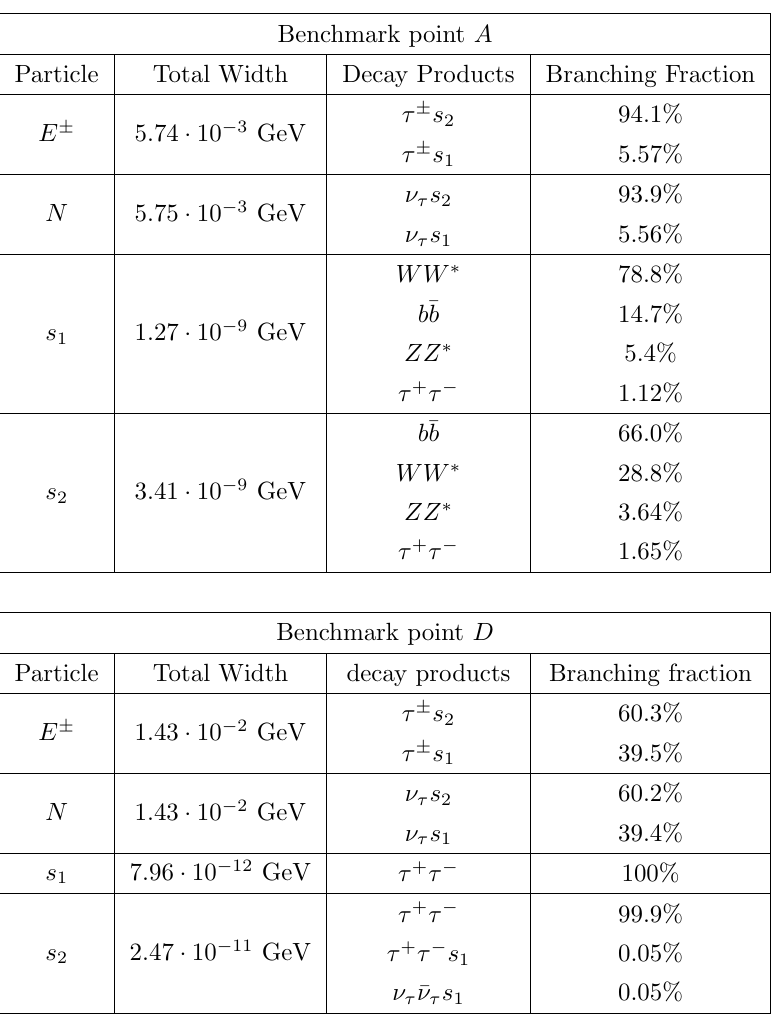
Table 4. List of particle widths, decay modes, and branching fractions as calculated by MadGraph5 (via MadWidth ) for benchmark points A and D . Benchmark points A and D were selected in order to illustrate the e(cid:11)ect of s i - h mixing, which is not present in benchmark point D